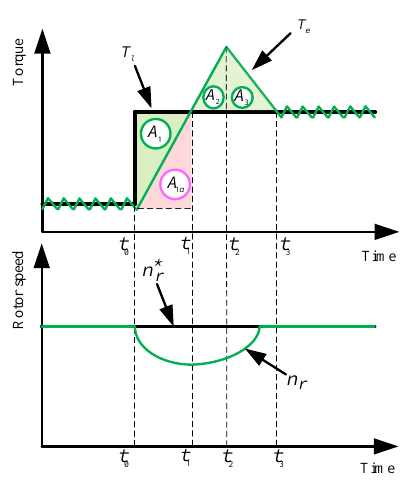
Figure 12. Optimal response to a sudden load sudden for the electromagnetic torque.